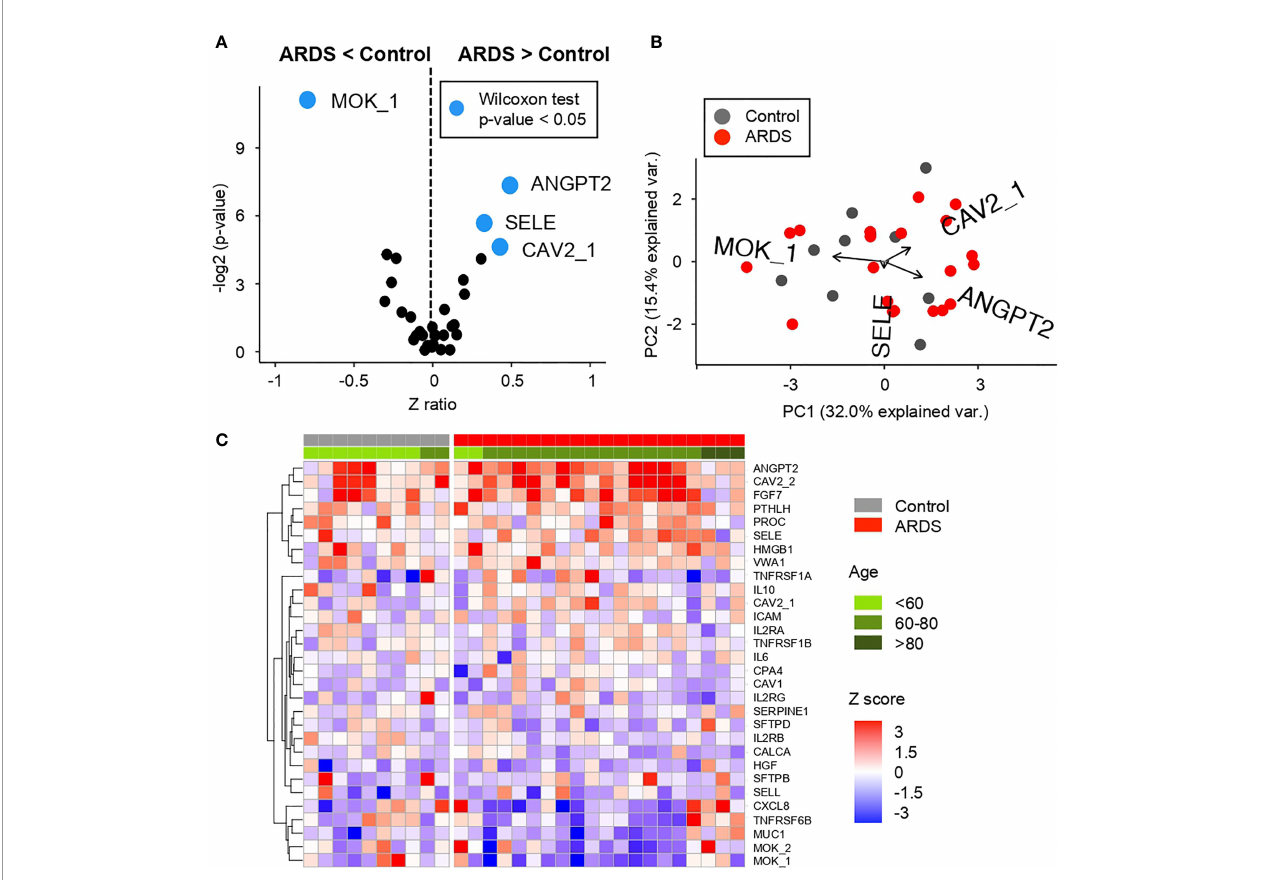
FIGURE 4 | Comparative analysis of the Z scores between control and ARDS patients in the cohort 1 obtained from the microarray for AABs (A) Volcano plot summarizing the statistical signi fi cance of Z score ratios between control and ARDS patients in the cohort 1 (X-axis). The difference between means was evaluated applying Wilcoxon Rank Sum test (Y-axis). AABs showing statistically signi fi cant mean differences are highlighted in blue and larger dots. (B) Canonical biplot representing the PCA of the microarray for AABs employed in the cohort 1. Dots represent samples and vectors the AAB variable contribution to the fi rst two principal components at X and Y-axes. The biplot only highlights the most exemplary AAB variables. (C) Heat map describing Z score values obtained from the microarray for AABs in cohort 1. Samples are separated by clinical symptoms (gray and red labeled columns) and ordered according to patient age (green color